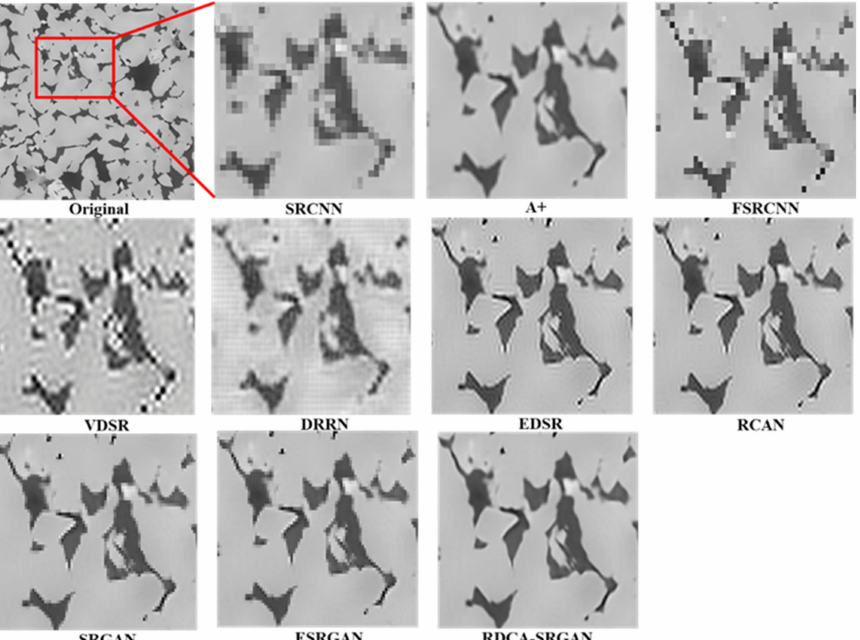
Figure 14. Comparison between HR images on sandstone and SR images generated using nine